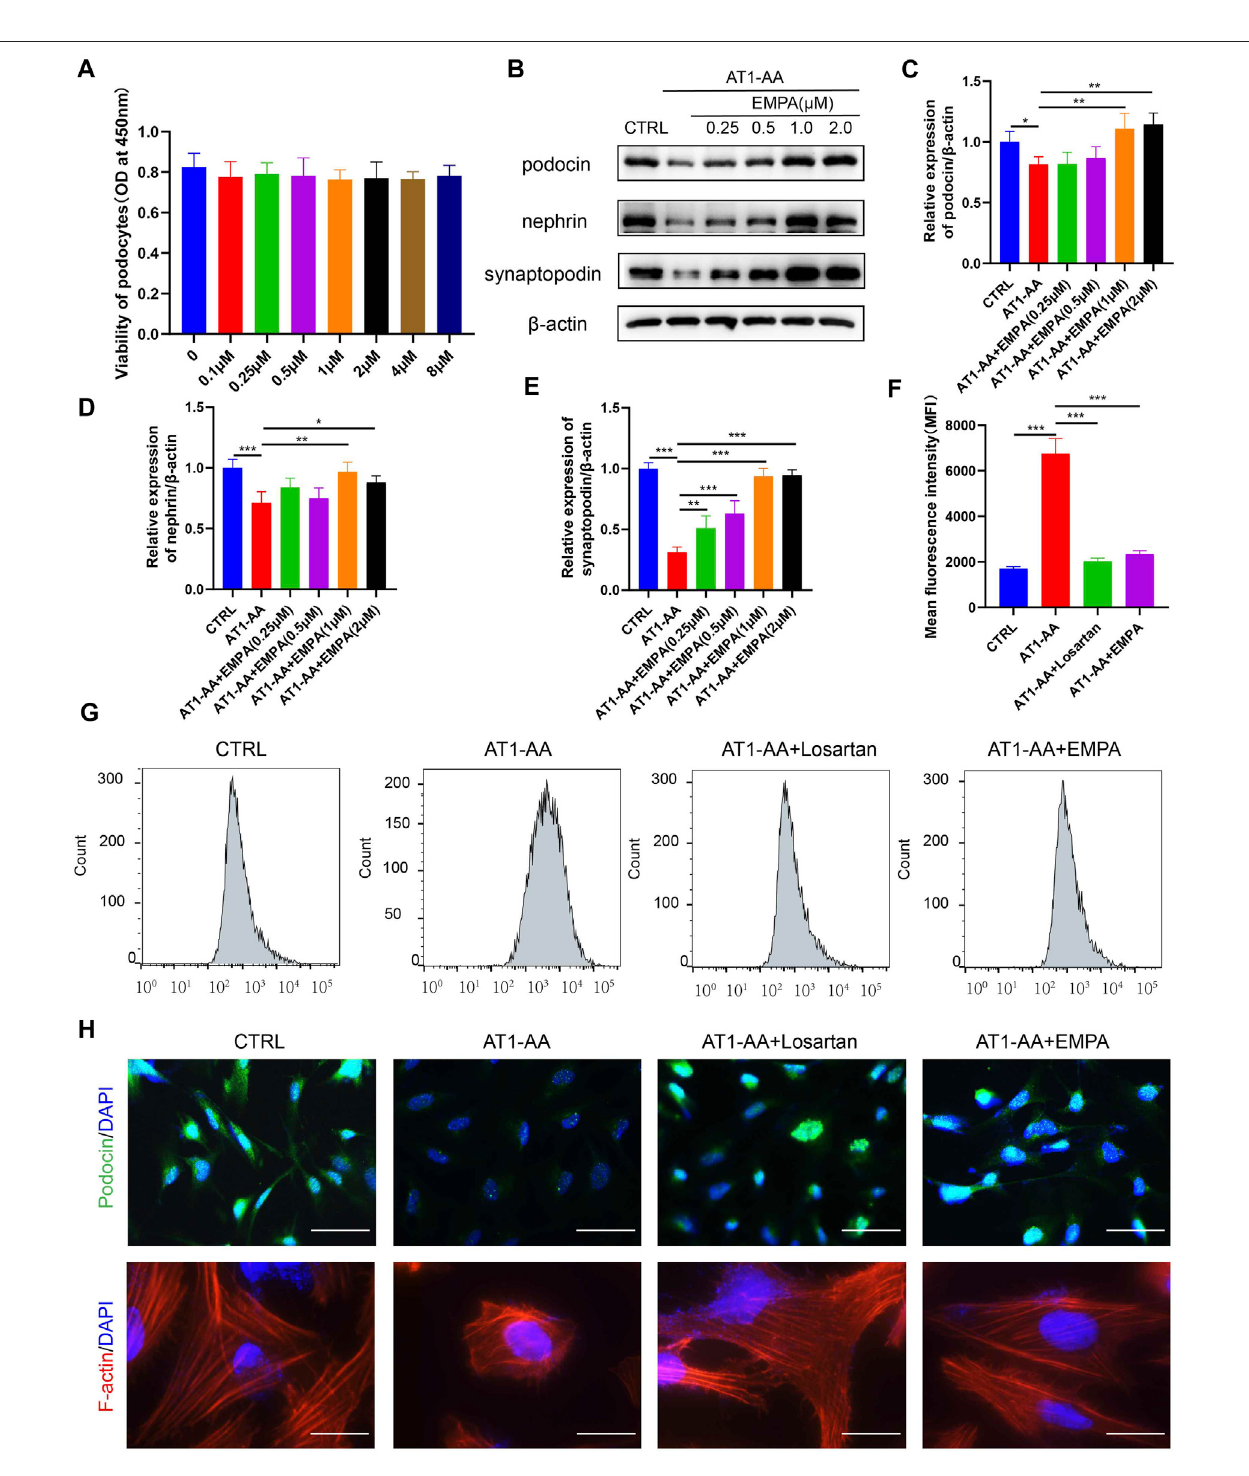
FIGURE 3 | EMPA limited AT1-AA-induced podocyte damage in vitro . (A) CCK8 assays of the effect of EMPA on podocyte viability ( n = 3). (B) Representative Western blots for synaptopodin, nephrin and podocin in cultured podocytes. Semiquantitative analysis of Western blots for (C) synaptopodin ( n = 3), (D) nephrin ( n = 3) and (E) podocin ( n = 3). (F) The graph displays the mean fl uorescence intensities (MFIs) obtained from fl ow cytometric analysis of intracellular ROS ( n = 3). (G) Representative fl ow cytometry histogram for DCF in the four groups. (H) Representative images of immuno fl uorescence staining for podocin and F-actin. Scale bars:upperpanel,50 μ m;lowerpanel,20 μ m.Dataareexpressedasthemean±SEMandwereanalyzedbyANOVAwithLSDposthoctest.* p < 0.05,** p < 0.01,*** p <